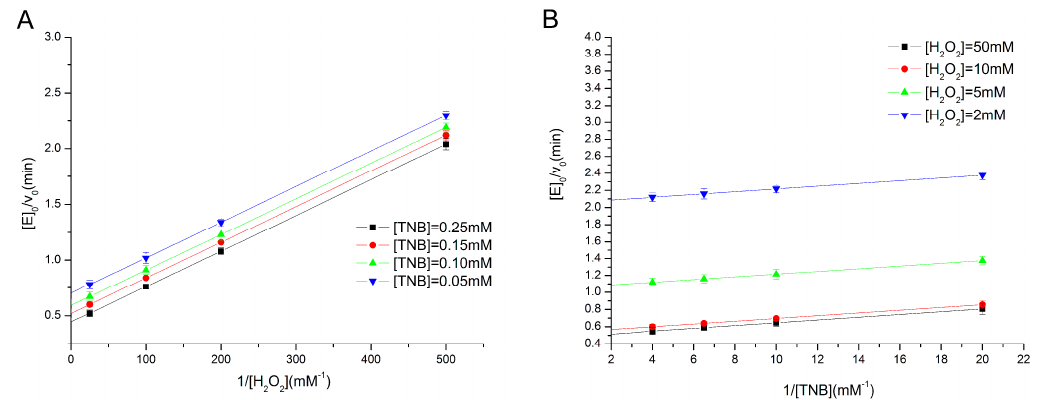
Figure 2. Double ‐ reciprocal plots for the reduction of H 2 O 2 catalyzed by 6 ‐ TediCD in the TNB system. ( A ) [E] 0 / v 0 vs. 1/[H 2 O 2 ] (mM − 1 ). ( B ) [E] 0 / v 0 (min) vs. 1/[TNB] (mM − 1 ). [E] 0 / v 0 values were deduced from the equation below (Equation (1)) of a Ping ‐ Pong kinetic mechanism.